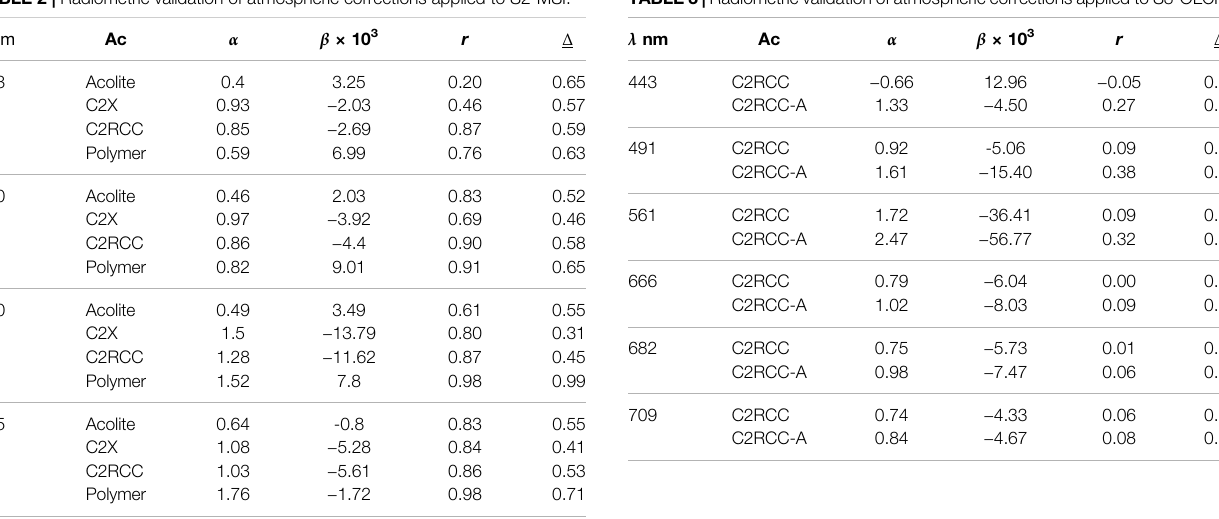
TABLE 2 | Radiometric validation of atmospheric corrections applied to S2-MSI.